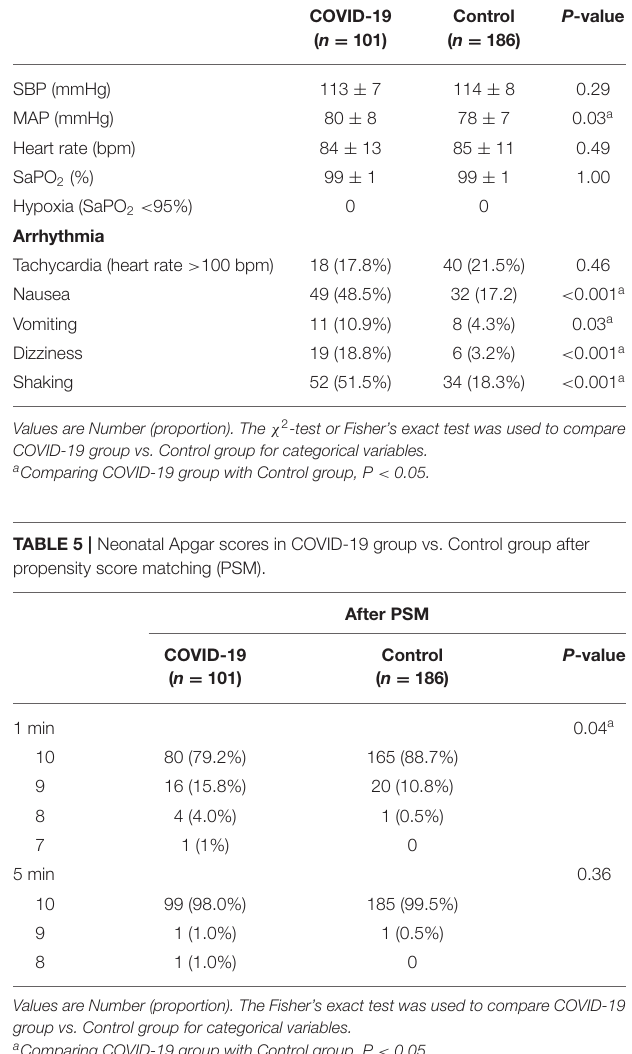
TABLE 6 | Neonatal Apgar scores from COVID-19 parturients with or without hypotension. COVID-19 parturients After PSM With hypotension ( n =